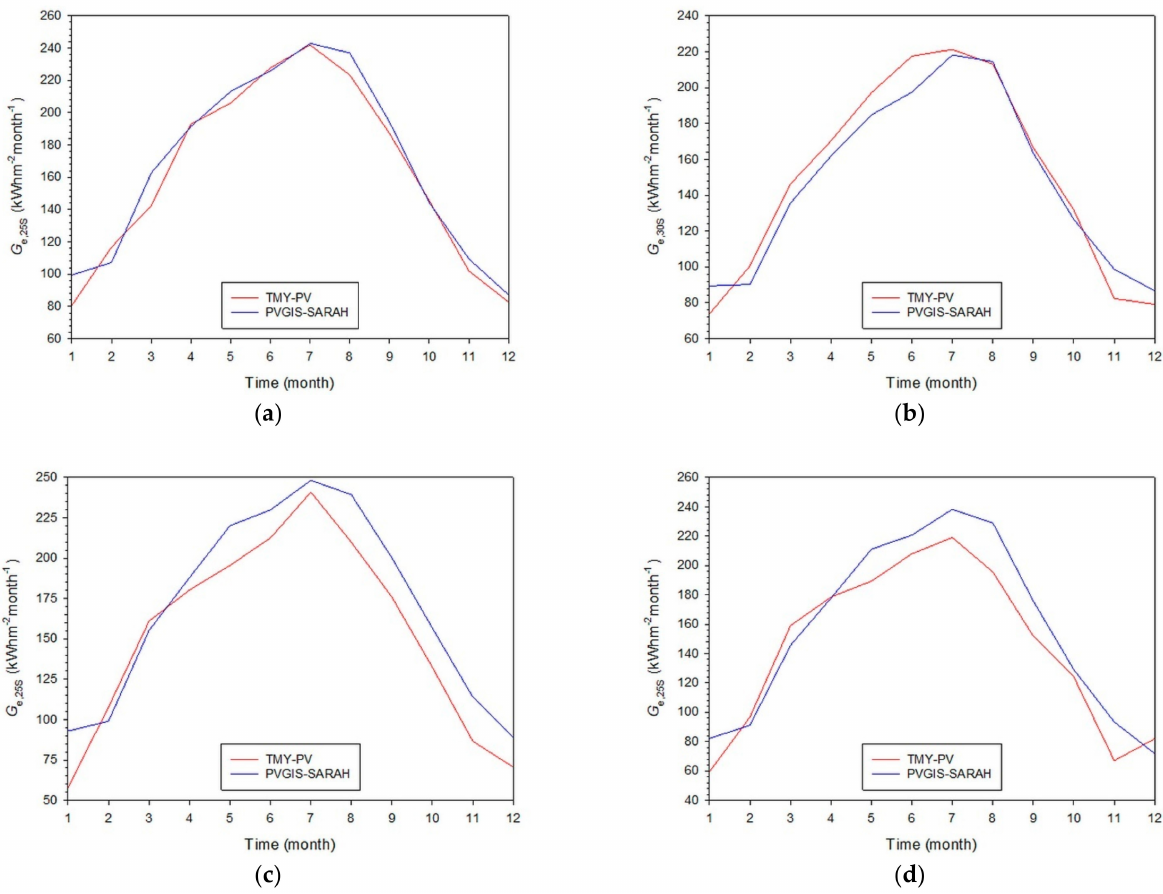
Figure 12. Intra-annual variation of the monthly G e ,25S or G e ,30S sums for Souda ( a , PV ctts zone A), Kozani ( b , PV ctts zone B), Chios ( c , PV ctts zone C), and Skyros ( d , PV ctts zone D). The red curves are estimates based on the corresponding photovoltaic typical meteorological year (TMY-PV) of the site, while the blue ones come from the Surface Solar Radiation Data Set—Heliostat (SARAH) 2005–2016 database using the PV Geographical Information System (PV-GIS) tool. The agreement between the two approaches is remarkable. In all cases, the correlation coefficient between the two curves is high: ( a ) 0.9736, ( b ) 0.9852, ( c ) 0.9679, and ( d )